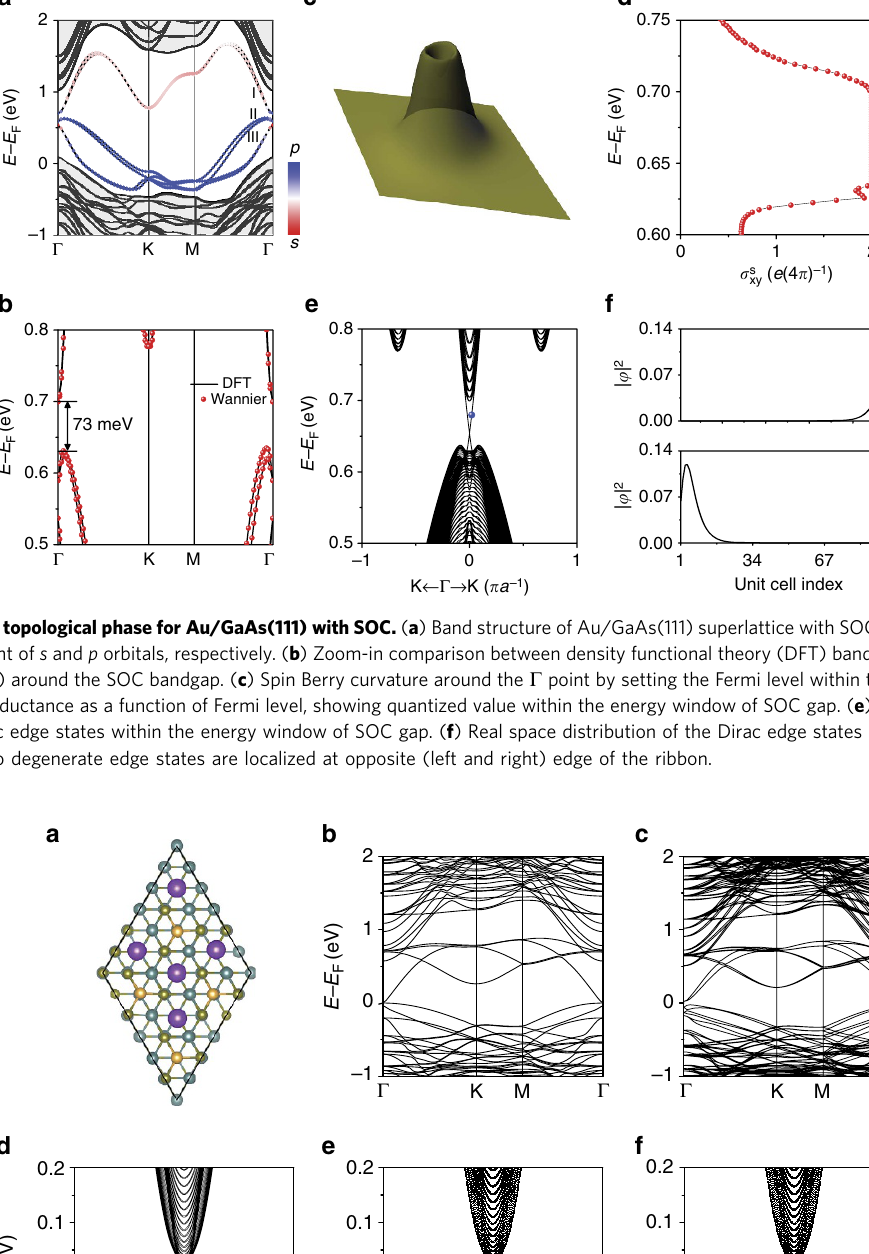
conductance and edge states by using the fitted Wannier ¼ 2 C s (cid:3) e ) is Hamiltonian. The spin Hall conductance ( s s xy 4 p defined based on the spin Chern number ( C s ), which can be calculated from the spin Berry curvature by using standard Kubo